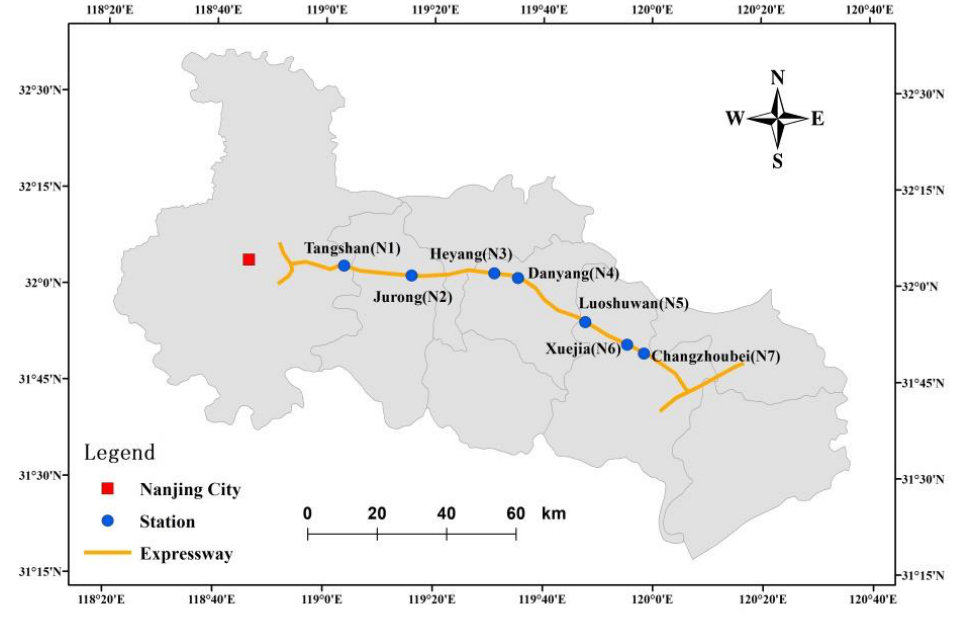
Figure 3. Research area and exit distribution.